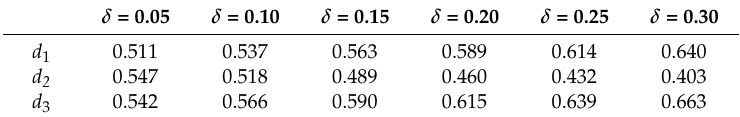
Table 4. Changes of desirability function values according to the rate of relaxation ( h = 1).